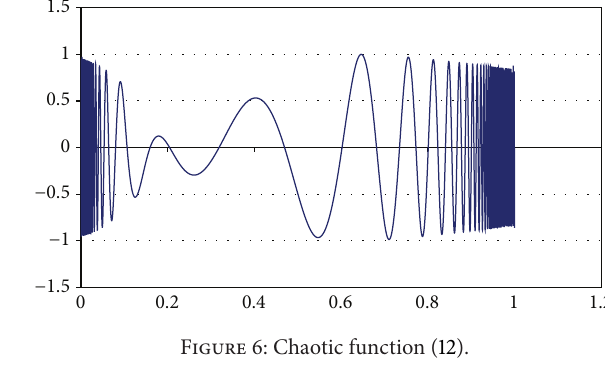
Figure 6: Chaotic function (12).